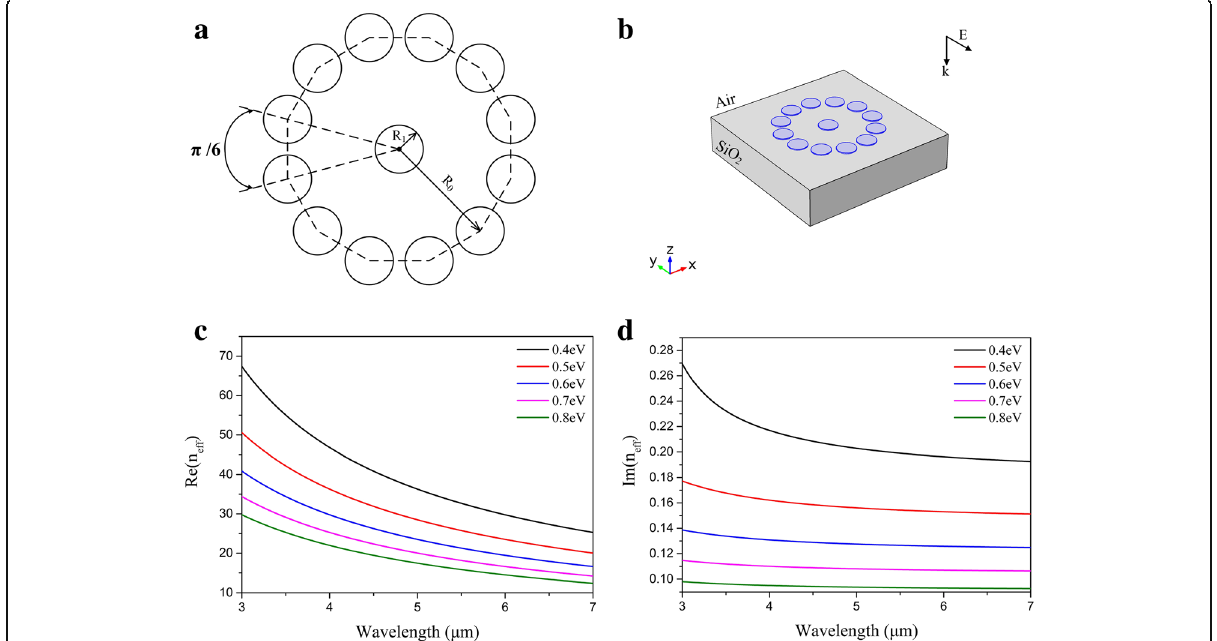
Fig. 1 a The schematic diagram of the graphene oligomer with symmetry D 12h consisting of 13 identical graphene disks. b The simulation model of graphene oligomer. The graphene oligomer is placed on the silica substrate with n 2 = 1.5 and is surrounded by air with n 1 = 1. c , d The real part and imaginary part of n eff with the chemical potential of graphene ranging from 0.4 to 0.8